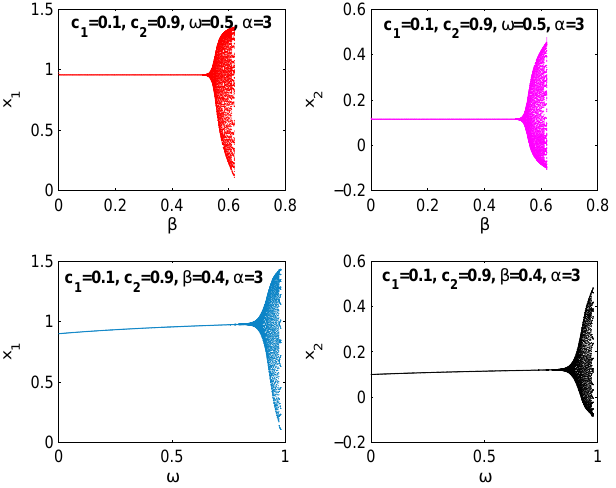
Figure 4. Bifurcation diagrams on varying the parameters β and ω at the parameters’ values, c 1 = 0.15, c 2 = 0.9 and α =